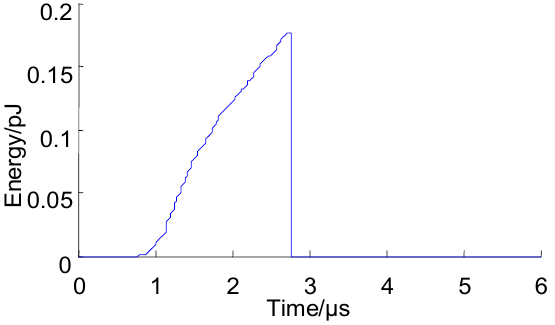
Figure 8. Cumulative energy of PD UHF